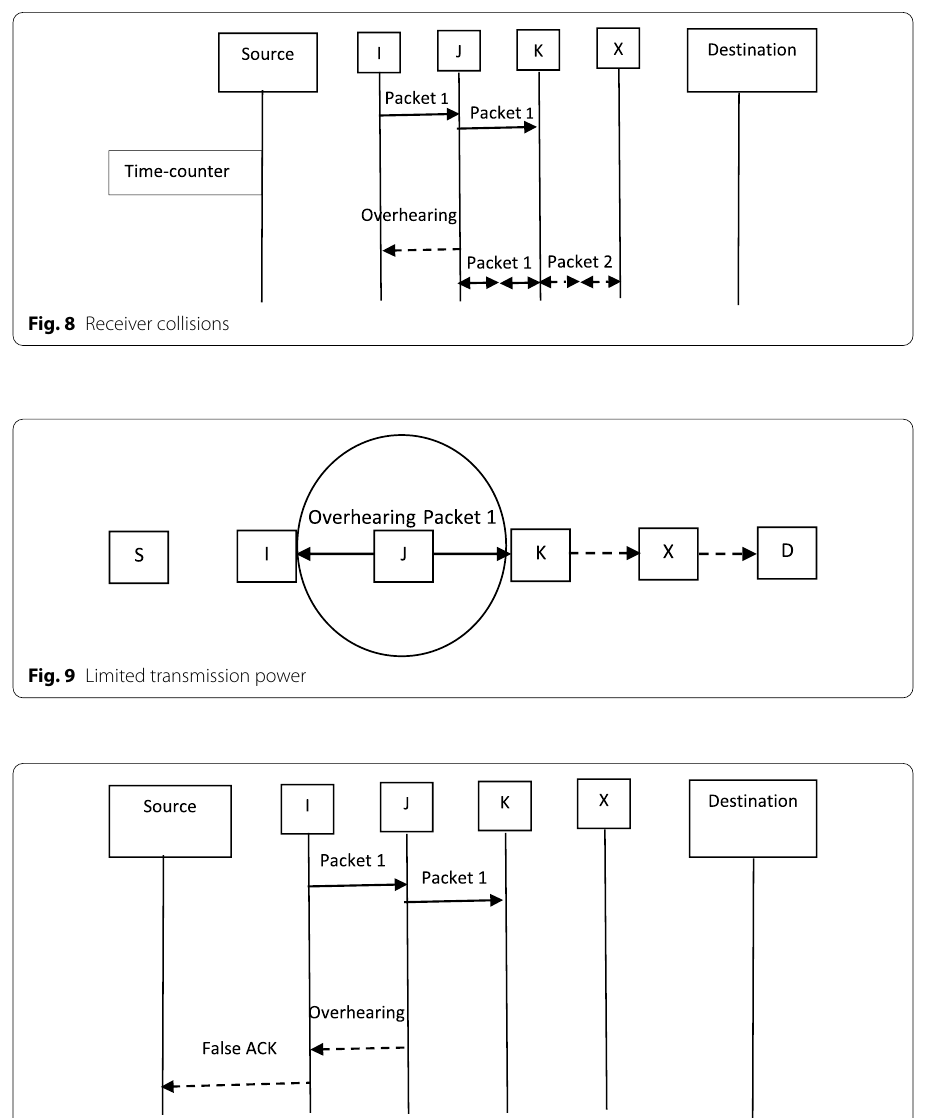
Fig. 10 False misbehaviour